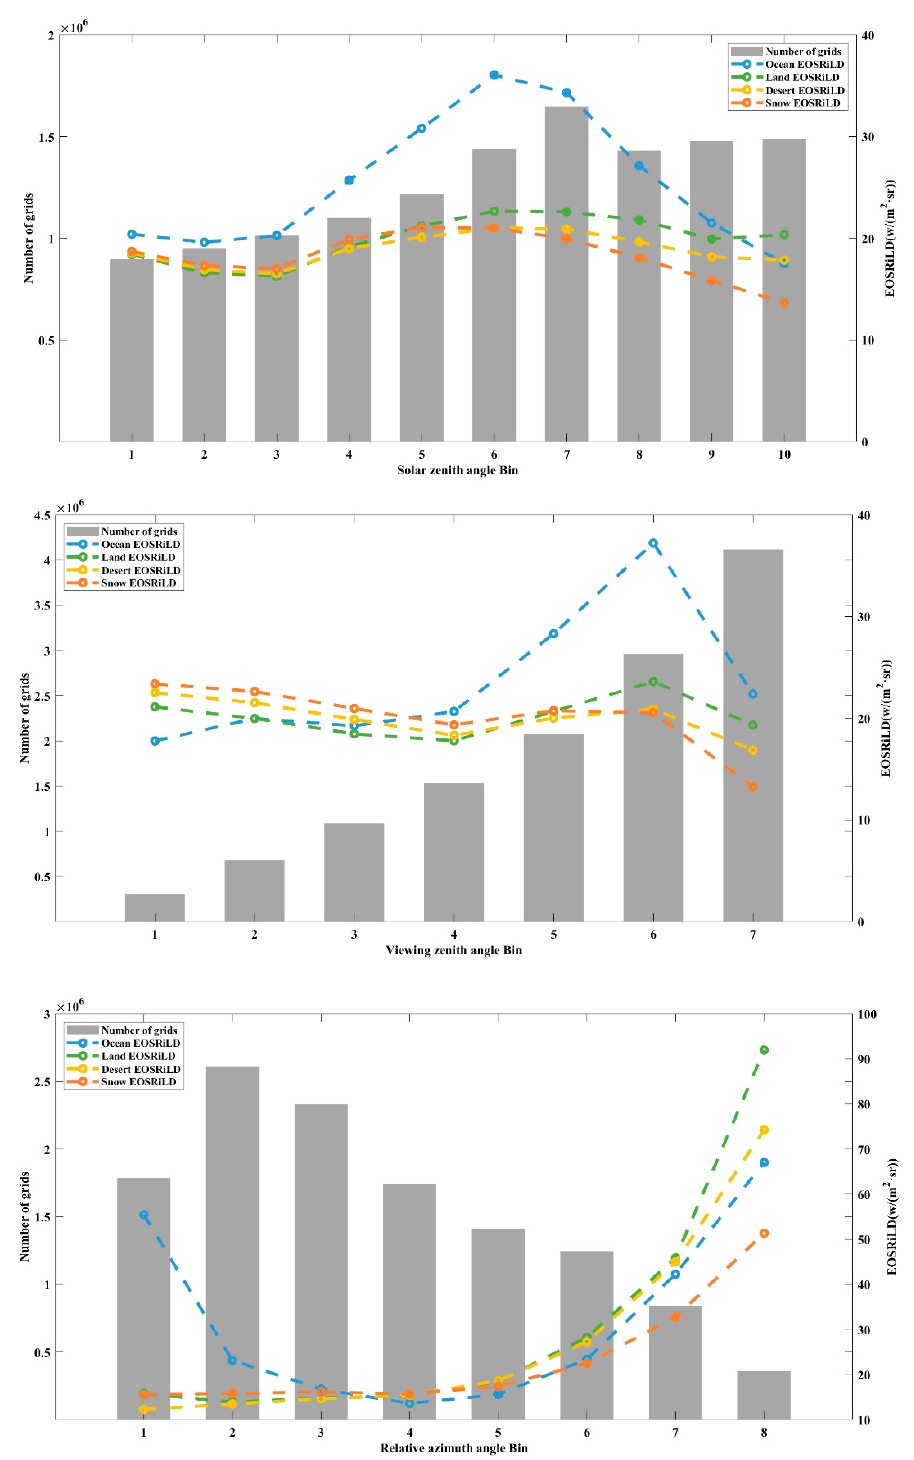
Figure 15. Schematic of sets of data at the same time.